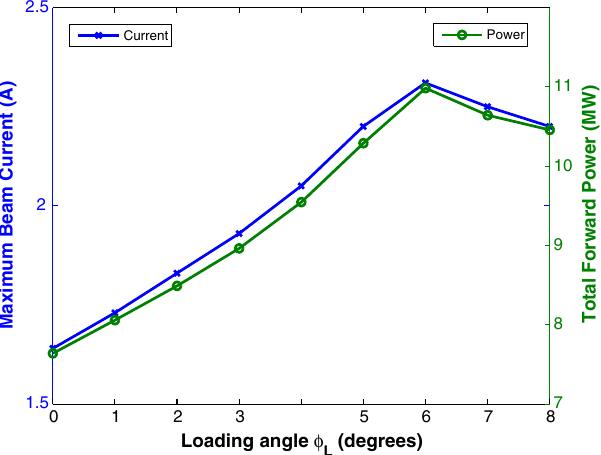
FIG. 6. (Color) HER growth rates of the most unstable low-order beam mode (mode (cid:1) 3 . L